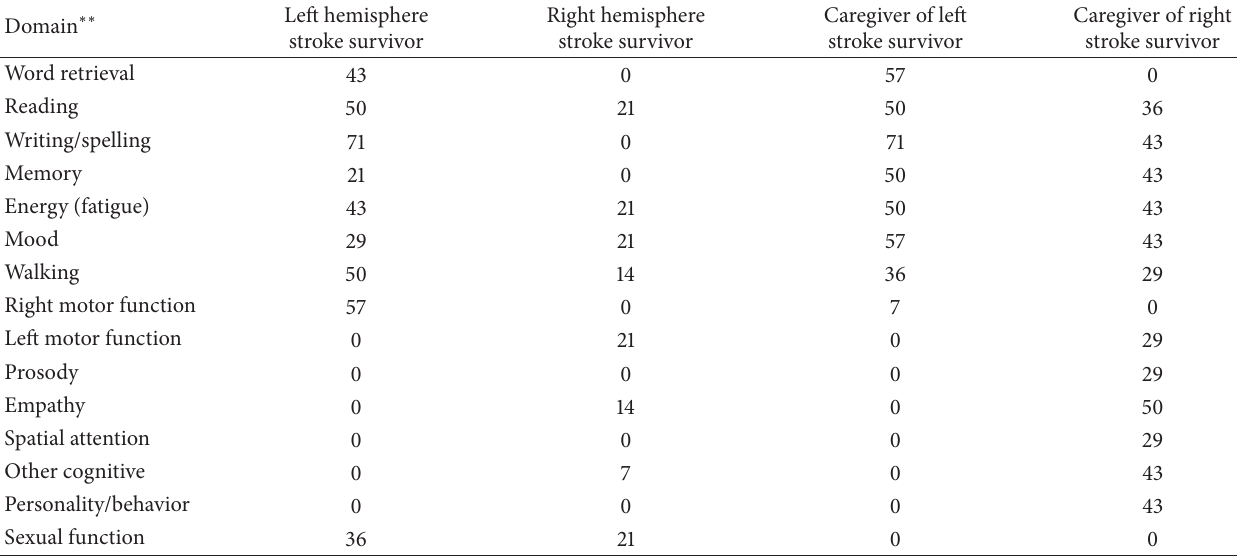
Table1: Sequelaereportedbystrokesurvivorsandtheircaregivers(inpercent)whoreportedimpairmentasoneofthe“top5”mostimportant problems or moderate/important problems ( 𝑛 = 14 each group) ∗